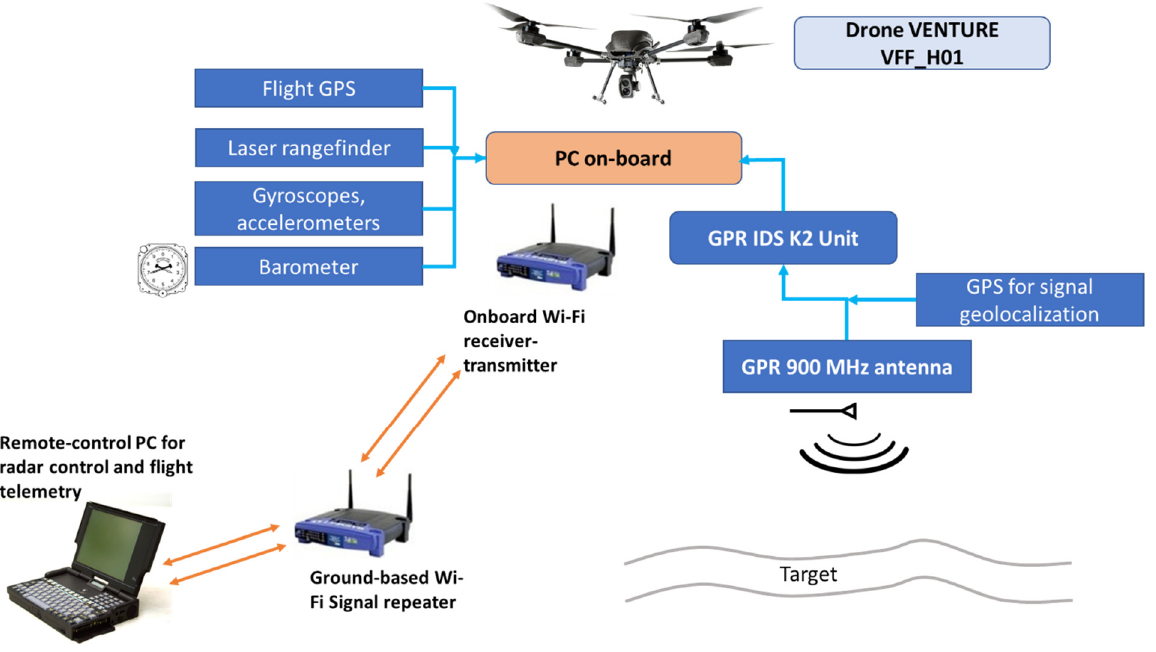
Figure 1. Scheme of the drone coupled with a 900 MHz antenna.